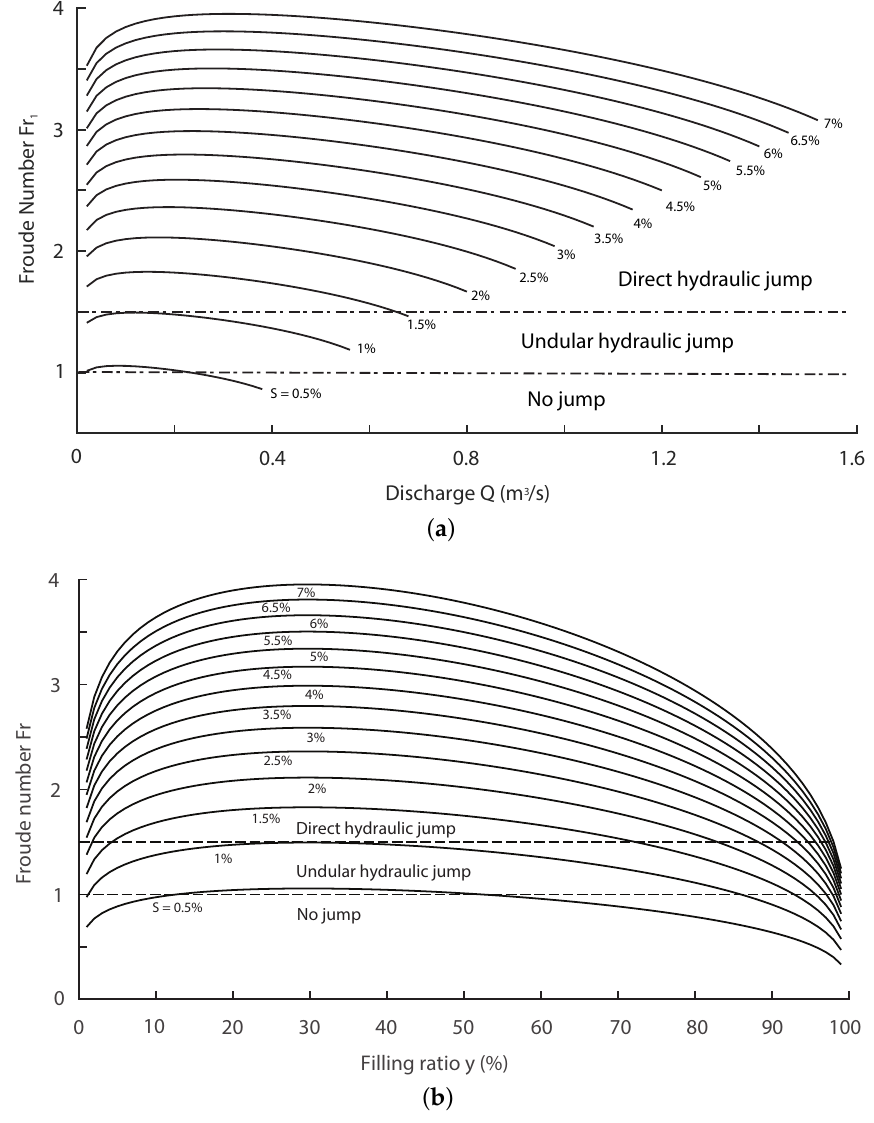
Figure 6. Froude numbers in a circular pipe at a range of pipe slopes, in relation to: ( a ) discharge; ( b ) filling ratio. The pipe diameter D is 600 mm. Manning‘s n equals to